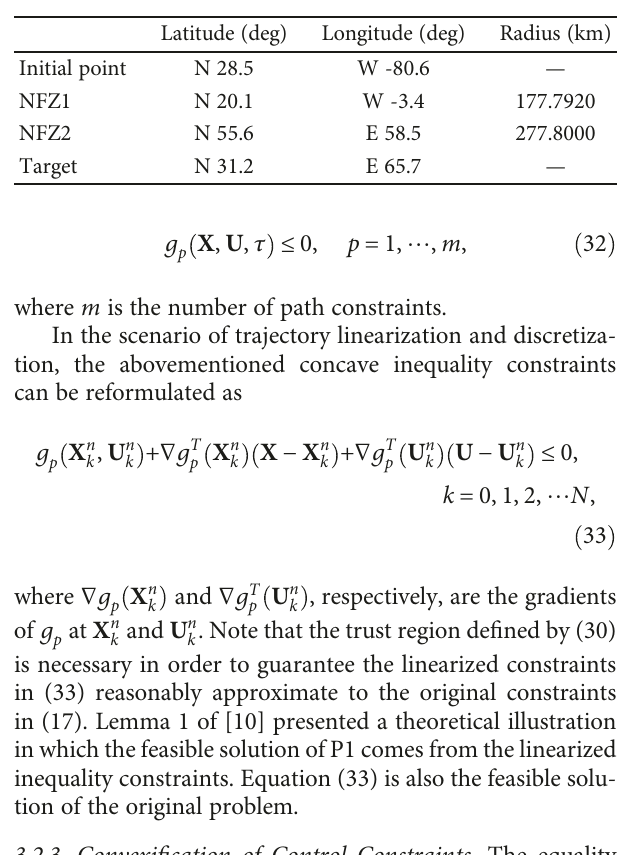
Figure 1: [18] Relaxation of control constraints. (Left) original nonconvex set: blue surface (10). (Right) relaxed convex set: blue cone includes its surface (34) Reproduced from Liu et al. [18] (under the Creative Commons Attribution License/public domain). Table 1: CAV mission